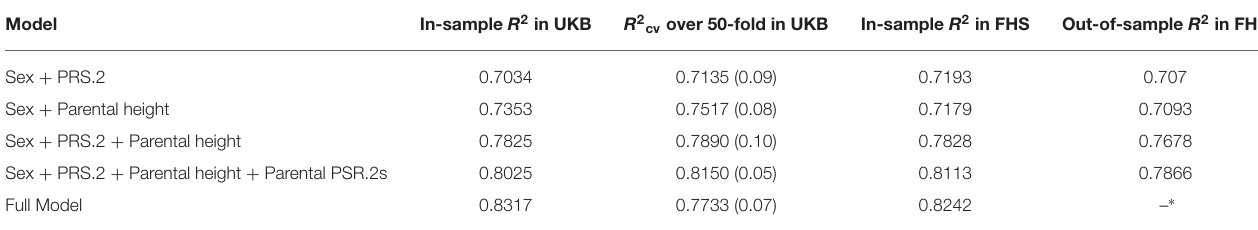
TABLE 3 | The R 2 of different models including PRS ++ .